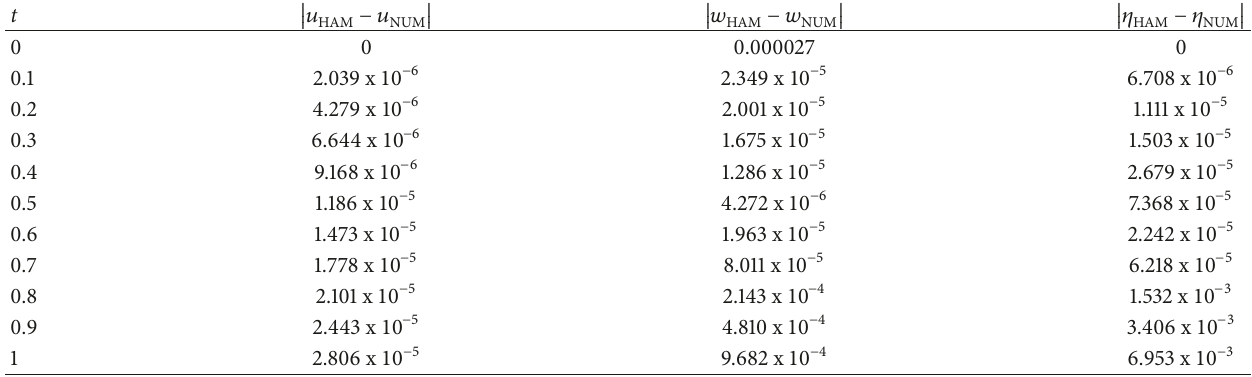
Table 1: An absolute error between the numerical and HAM solution at x = 0.1 and 0 ≤ 𝑡 ≤ 1